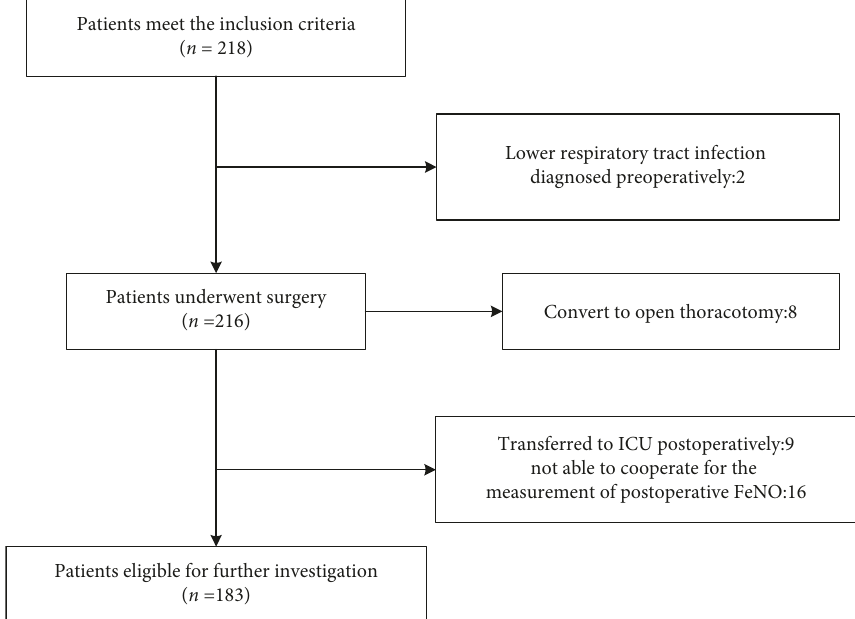
Figure 1: Flow chart of patient recruitment. FeNO: fractional exhaled nitric oxide; ICU: intensive care